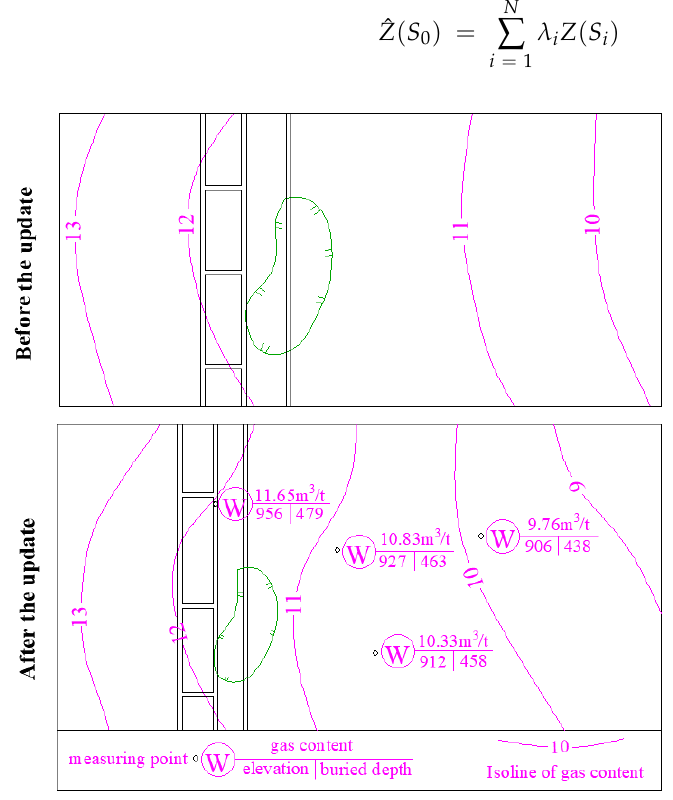
Figure 2. Comparison of gas content contour before and after update.